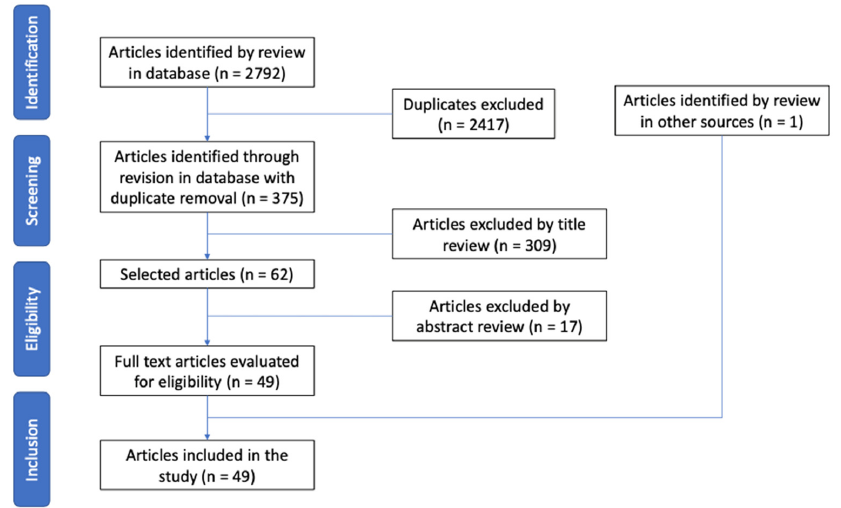
Figure 1. Flow chart for the selection of articles based on the PRISMA matrix.